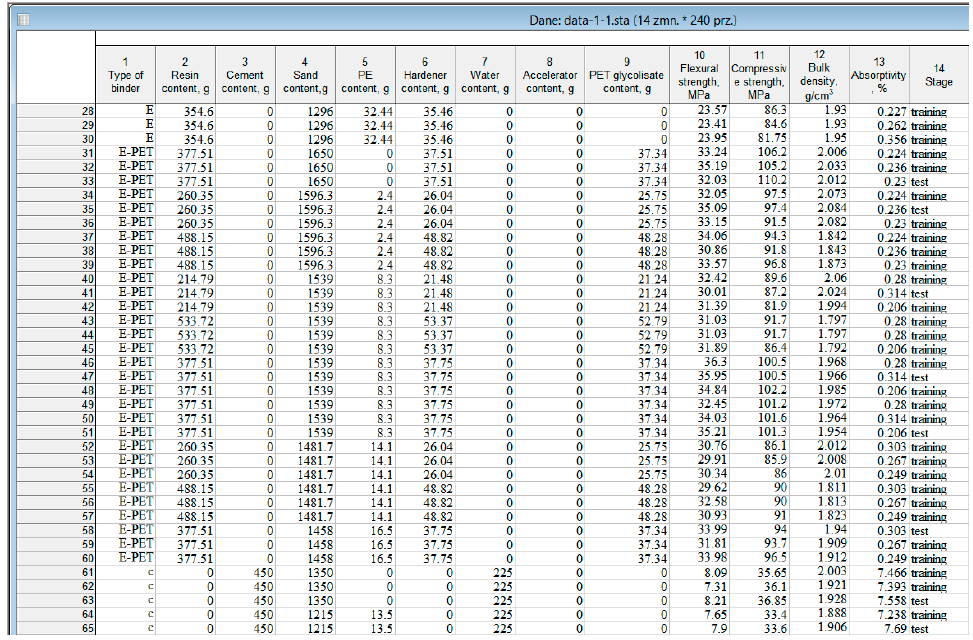
Figure 2. Diagram of the technological process of obtaining mortars.